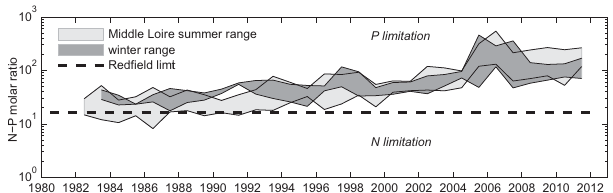
Figure 5. Variations of total nitrogen over total phosphorus molar ratios ranges during summer and winter in the Middle Loire (station 18) beginning in 1980 and compared to the Redfield limit (dotted line). Each patch is composed at the bottom by the 10th percentile of the recorded data and 90th percentile at the top; the y axis is